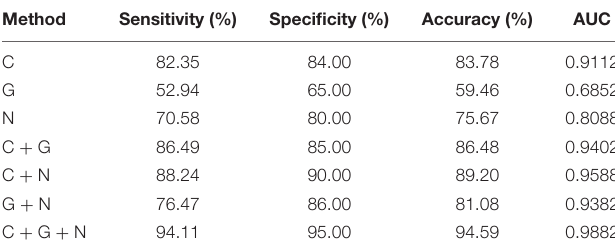
FIGURE 2 | The most consensus connections. The arc thickness indicates the discriminative power of an edge, which is inversely proportional to the estimated P -values.